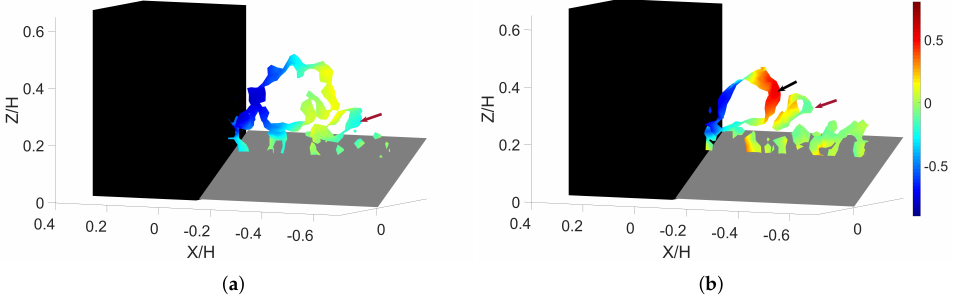
Figure 16. Instantaneous iso-surfaces of the dimensionless Q-criterion in a representative section over the channel bank at the upstream face of the retaining wall showing the ( a ) backflow, and ( b ) zeroflow modes of the JV1 vortex. The color coding corresponds to the vertical velocity